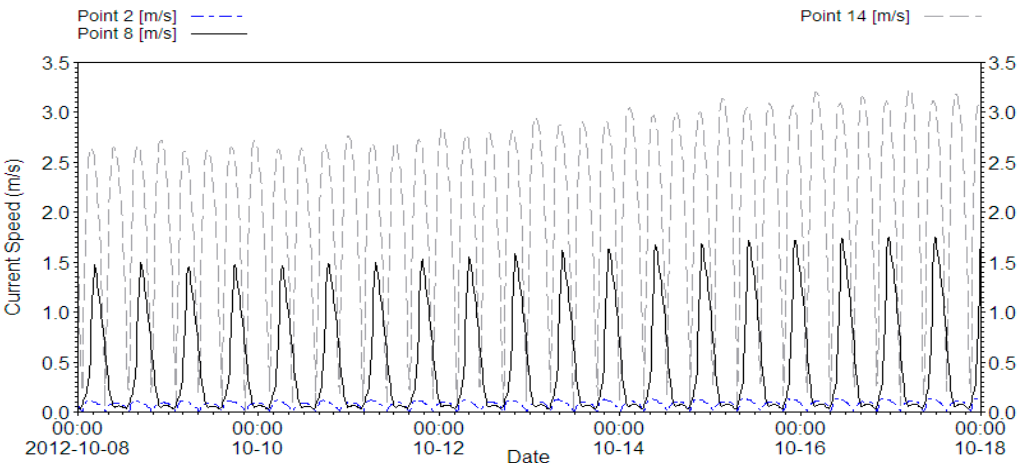
Figure 2. Current speed (m/s) at points 2 and 8 within the basin and 14 in the channel from the idealised model (see Figure 1 for positions of points).